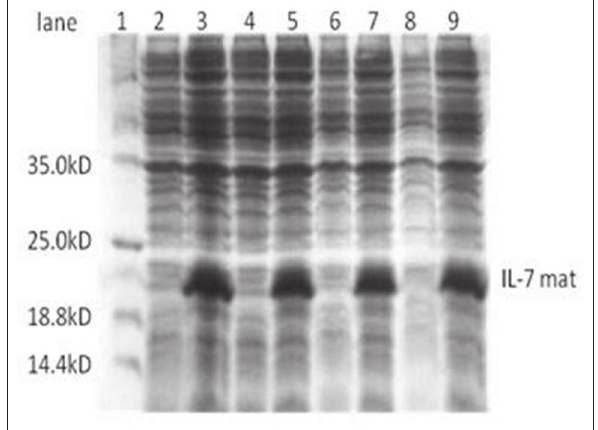
Figure-1: Polyacrylamide gel electrophoresis analysis of recombinant BL21c Escherichia coli colonies for bovine interleukin 7 mature protein expression. Randomly selected overnight grown cultures of recombinant colonies were inoculated to 10 ml Luria-Bertani broth medium and grown to optical density = 0.6-0.8 at 37°C. The culture 600 was induced with 1 m Misopropyl thiogalactosidasefor 5 h at 30°C. The pellet was lysed and analyzed by 10% sodium dodecyl sulfate-polyacrylamide gel electrophoresis gel for Figure-3: Western blotting analysis of recombinant bovine protein expression under denaturing conditions. Lane 1: interleukin 7 mature (bIL-7 mat) protein. Immunoblotting Molecular weight protein markers, Lane 2, 4, 6, 8: Cell of recombinant bIL-7 matprotein using antihuman IL-7 lysate of uninduced recombinant PET28-boIL-7mat/BL21c antibodies. Lane 1: Molecular weight protein markers, E.coli colonies, Lane 3, 5, 7, 9: Cell lysate of recombinant Lane 2: Purified IL-7 mature protein, and Lane 3: BL21 PET28-boIL-7mat/BL21c E.coli colonies after induction. cell